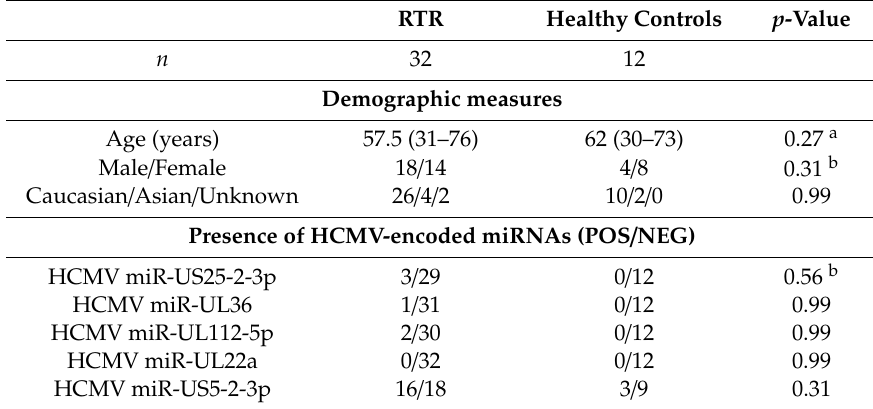
Table1. Demographicsdidnotassociatewiththepresenceofhumancytomegalovirus(HCMV)-encoded microRNAs (miRNAs). Table 1. Demographics did not associate with the presence of human cytomegalovirus (HCMV)- encoded microRNAs (miRNAs).